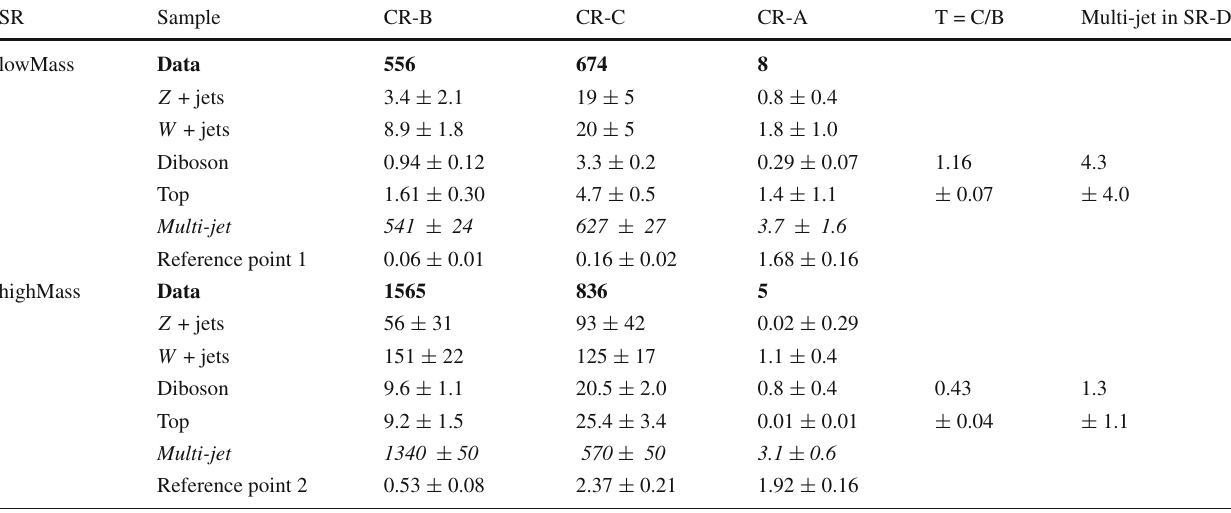
encepoints(definedinSect.3)inthecontrolregionsarealsoshown.The estimated multi-jet contribution in the SRs is given in the last column including both the statistical and systematic uncertainties. The details of the systematic uncertainties reported here are discussed in Sect. 7